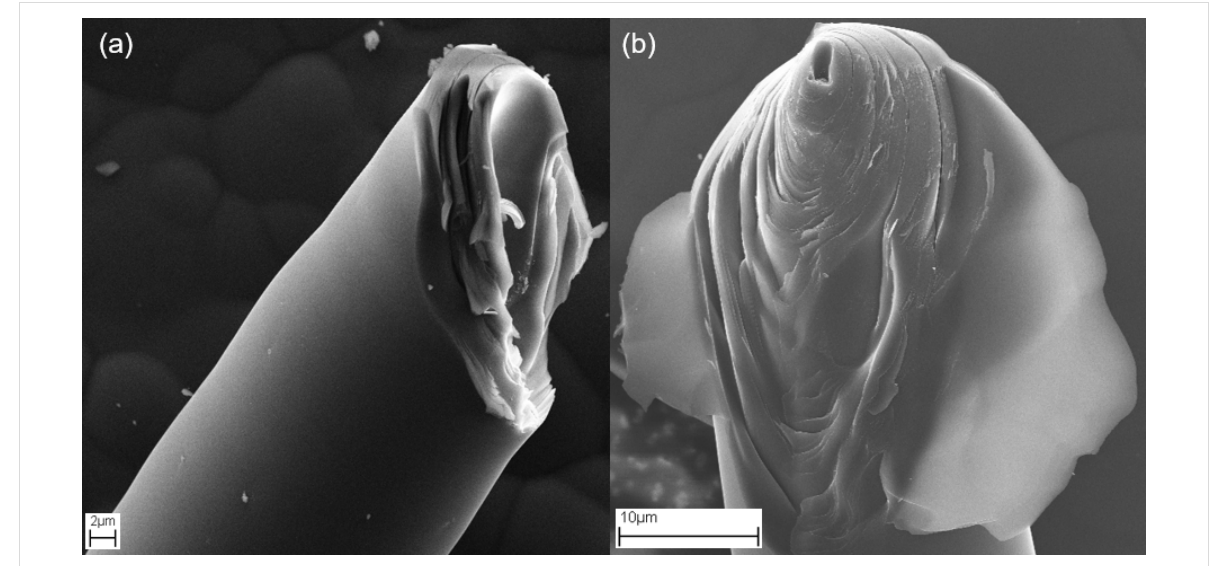
Figure 3: SEM images of two typical glassy carbon microneedles fractured at the tip showing that the microneedles have a hollow core and are tubular in structure.